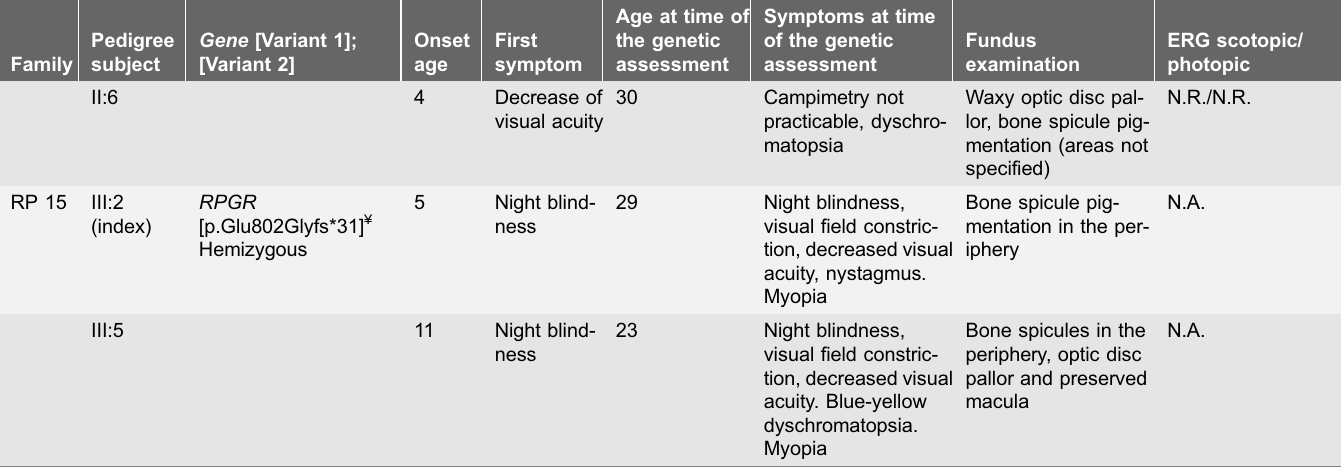
exome enrichment protocols. Reads alignment of this region is shown in S1A